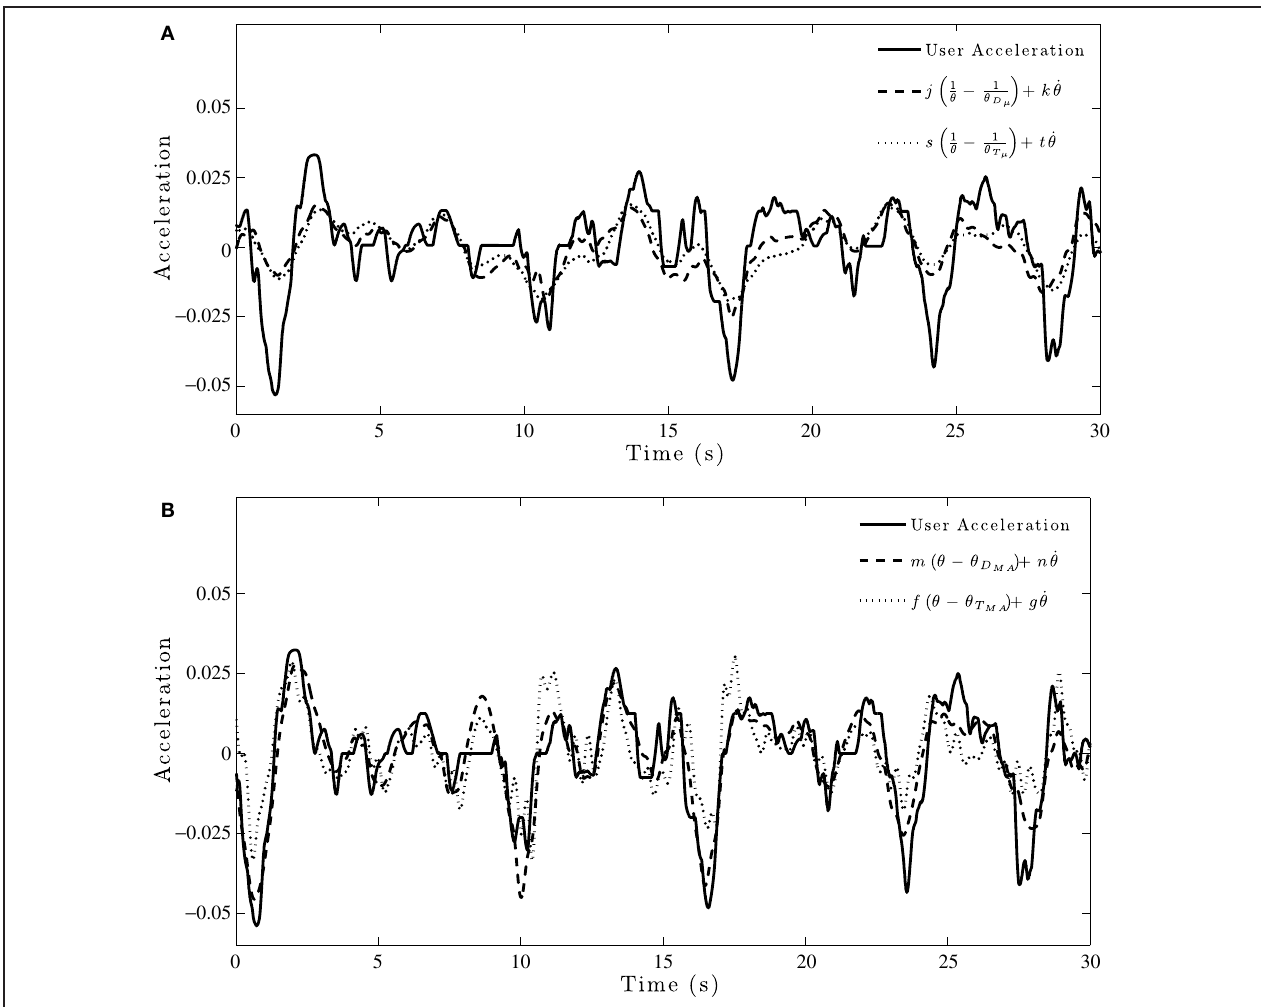
FIGURE 6 | Example model fit to individual acceleration-control data for a single trial. (A) Initial model fitting comparing θ D μ and θ T μ models. (B) Model and θ T models. fits for comparison of optimized θ D MA MA